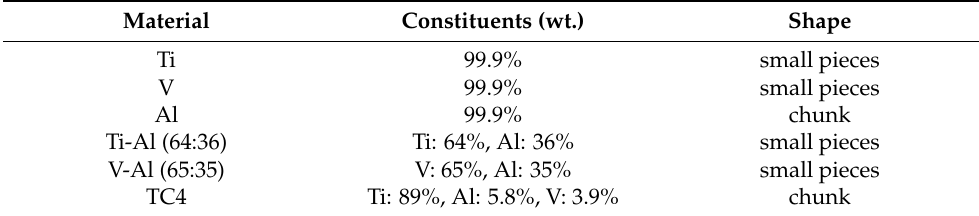
Table 1. The raw materials in this study. Material